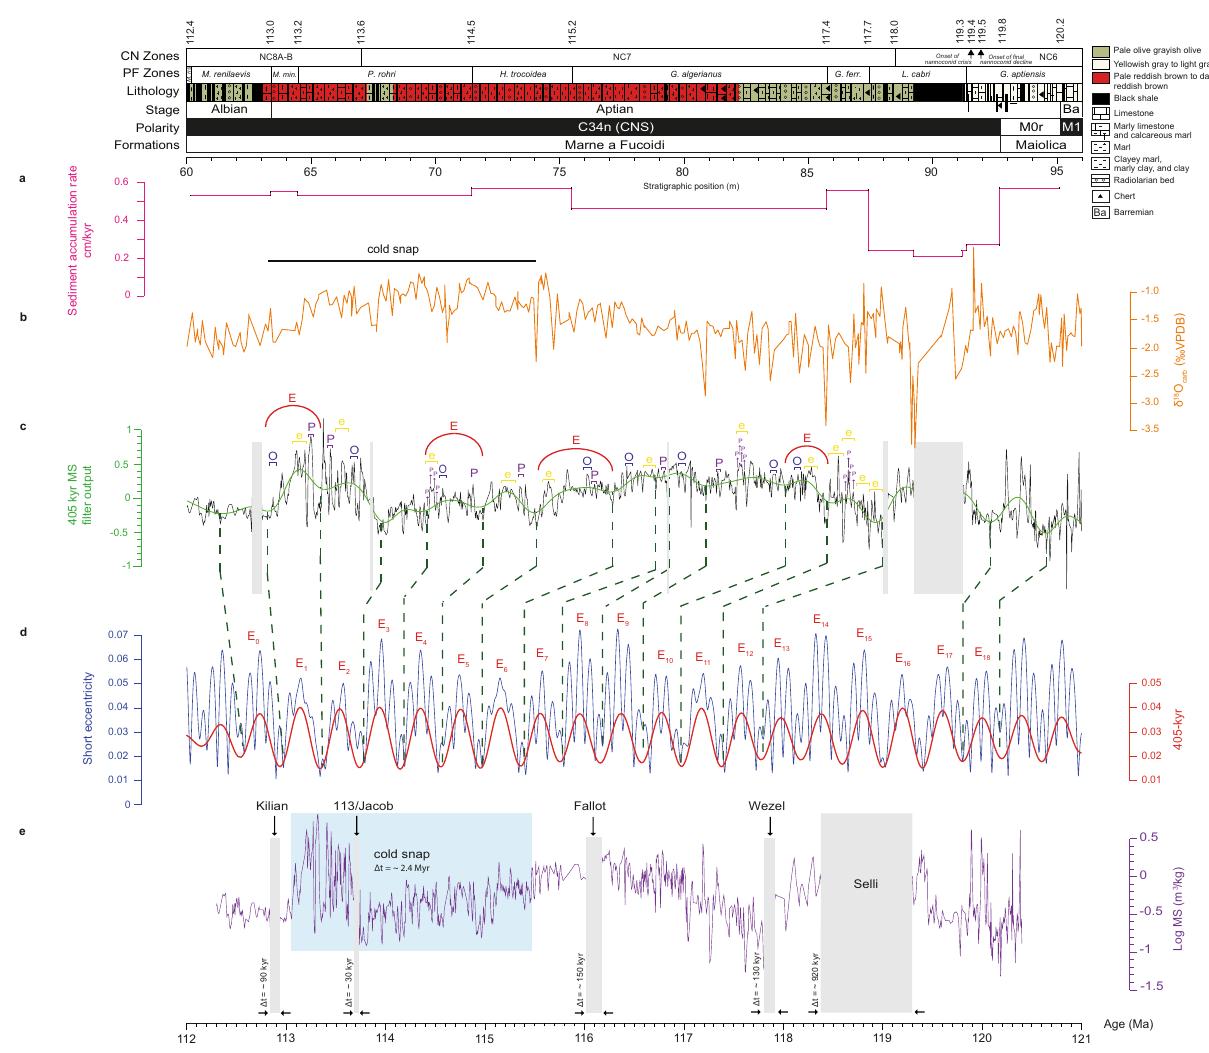
Fig. 4 Astronomical calibration of the PLG. a Sediment accumulation rate (SAR) curve based on 405-kyr tuning (pink); b δ 18 O (orange); c logarithmic- scale magnetic susceptibility (MS) data with linear interpolation and detrending linear (black line) and 405 kyr fi lter output (green line); d La2004 orbital solutions 39 for the eccentricity cycles of ~100 kyr (blue line) and ~405 kyr (red line); e data calibrated by long eccentricity (purple). The gray bands highlight the Selli, Wezel, Fallot, 113/Jacob and Kilian Levels and the blue band represents the cold snap interval. Formations, lithology and planktonic foraminiferal zones 11,32,45 and this work, calcareous nannofossil zones (this work), polarity 33 and stage (this work) for the PLG core. M. Microhedbergella, ris. rischi , min. miniglobularis , P. Paraticinella, H. Hedbergella, G. Globigerinelloides ferr. ferreolensis , L. Leupoldina . E long eccentricity (red bundles), e short eccentricity (yellow bundles), O obliquity (blue bundles), P precession (purple bundles).